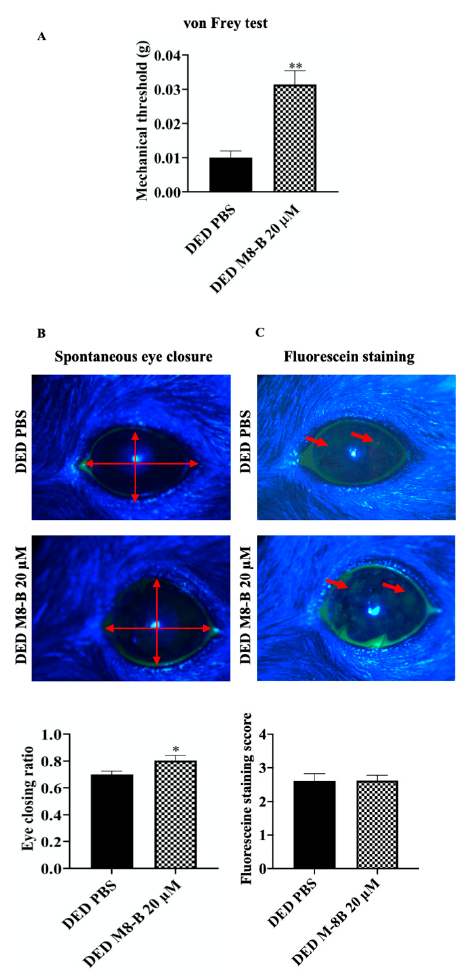
Figure 7. Mechanical allodynia and corneal epithelial damage in DED mice treated with M8-B (20 µM) vs. PBS. ( A ) Corneal mechanical sensitivity measured with von Frey filaments (g: gram). ( B ) Images and quantification of spontaneous eye closing ratio calculated by measuring the width: height ratio. ( C ) Cornea alteration was examined using a slit-lamp microscope with a cobalt blue filter after placing a drop of fluorescein (0.5% Fluorescein Faure) in the right eye of the animals. The punctuate keratitis (red arrows) was quantified using standard grading scale, 21 days after surgery in DED mice treated